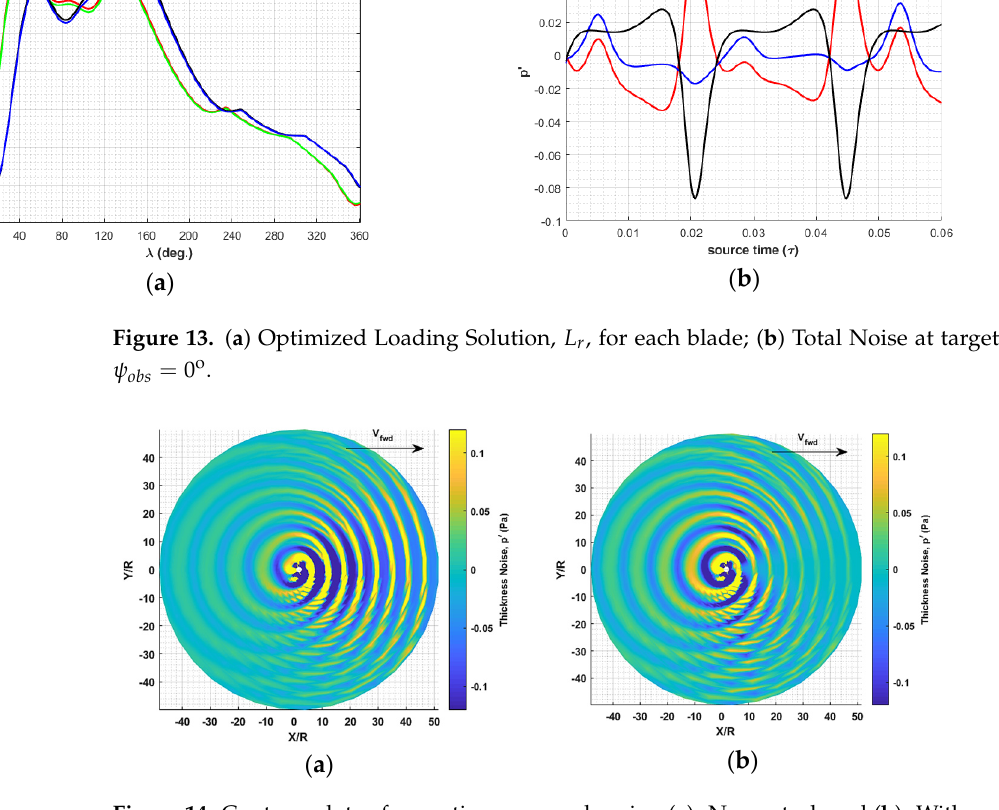
Figure 14. Contour plots of acoustic pressure showing ( a ): No control, and ( b ): With control for a zone of observers [55].